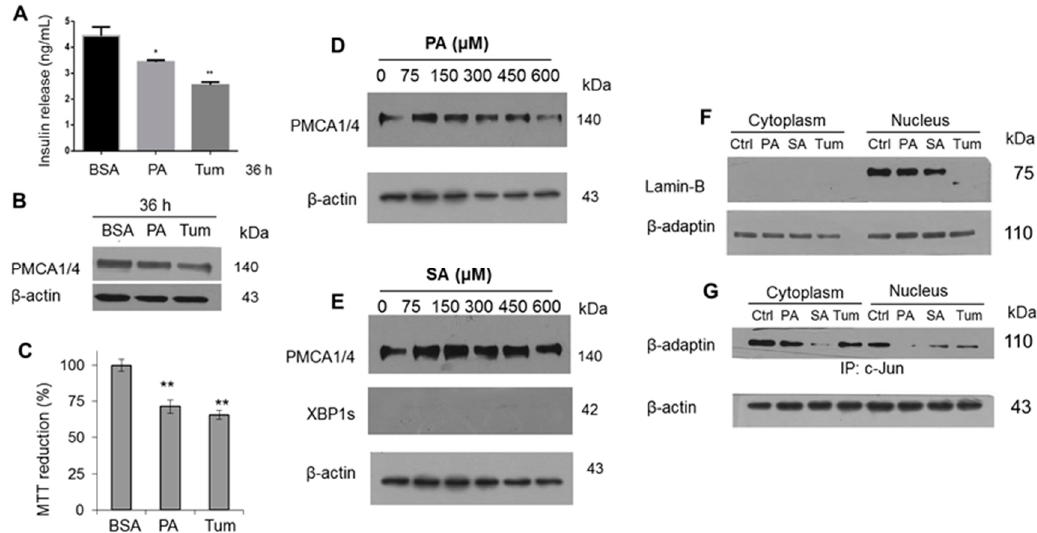
Figure 5. Endoplasmic reticulum stress reduces insulin secretion modifying the expression of PMCA1/4 and nuclear complexes. ( A ) Effect of treatment with PA and Tum on insulin secretion ( n = 3, mean ± SD) * p < 0.05, ** p < 0.01. ( B ) Western blot characterization of PMCA1/4 isoforms. ( C